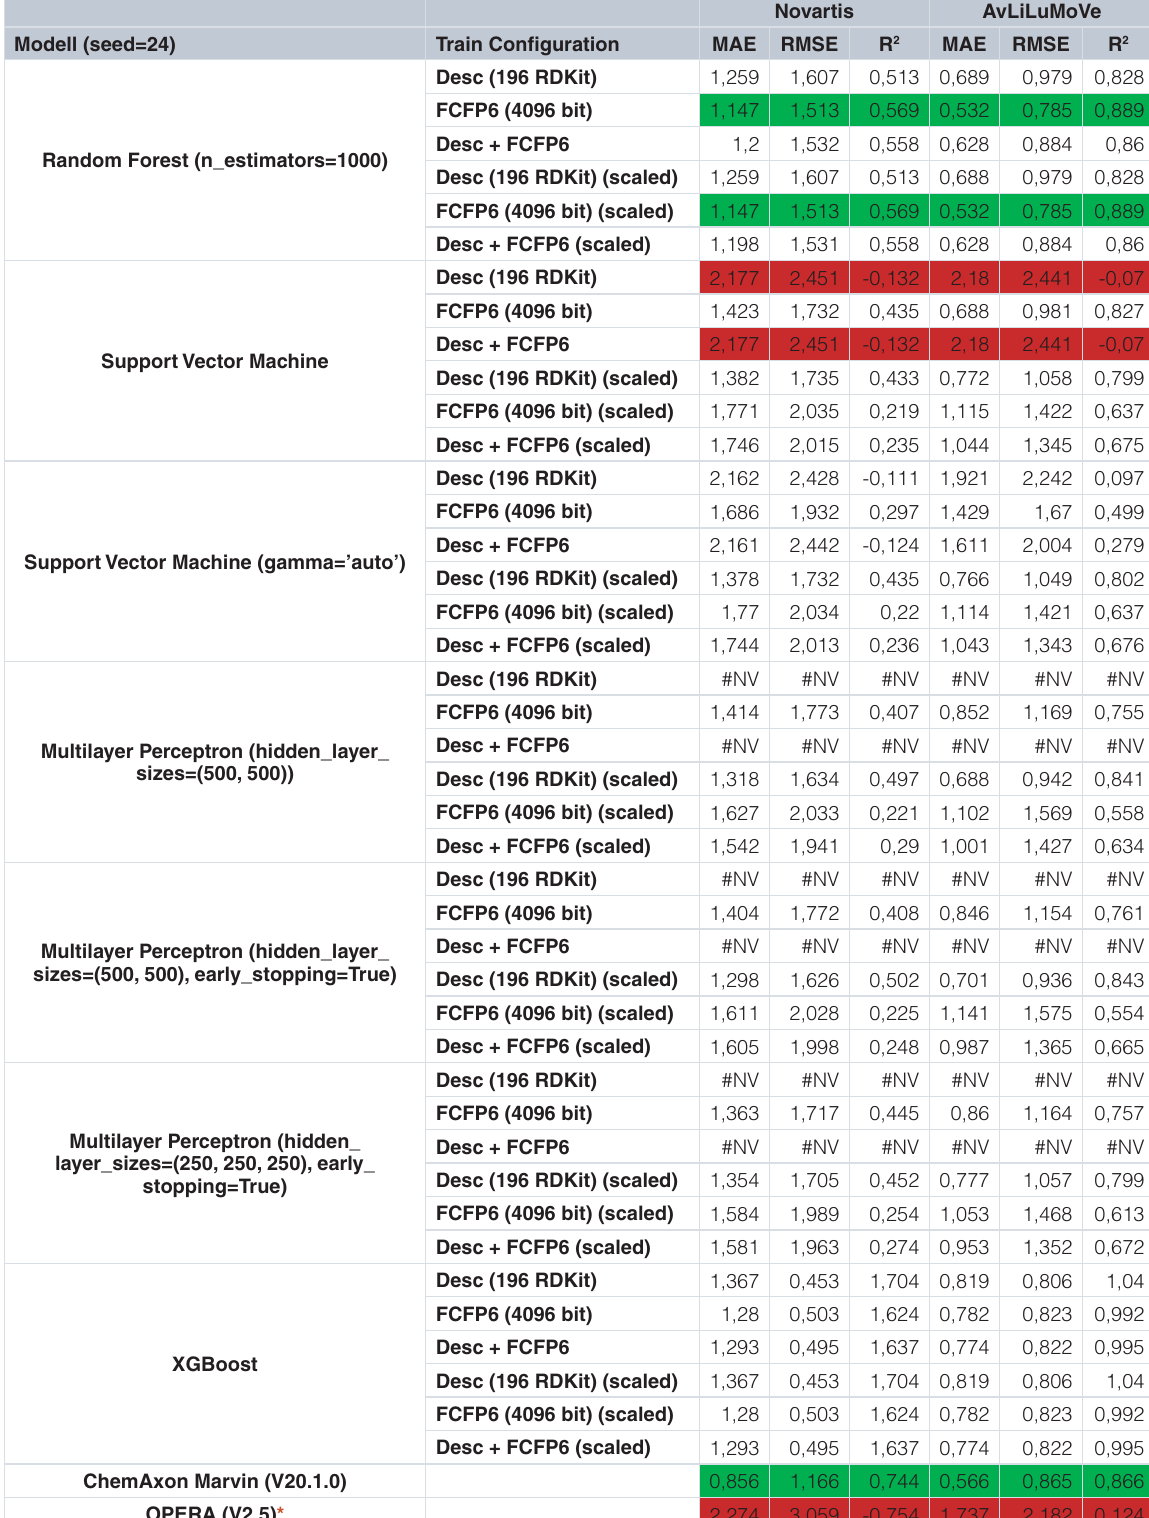
Table 2. Predictive performance of the machine learning models the on the two external test sets. The two best and worst performing models are highlighted in green and red. For those neural networks where the values were specified as “not available” (“#NA”), the weights could not be optimized properly due to the large value range of the RDKit descriptors, so training failed